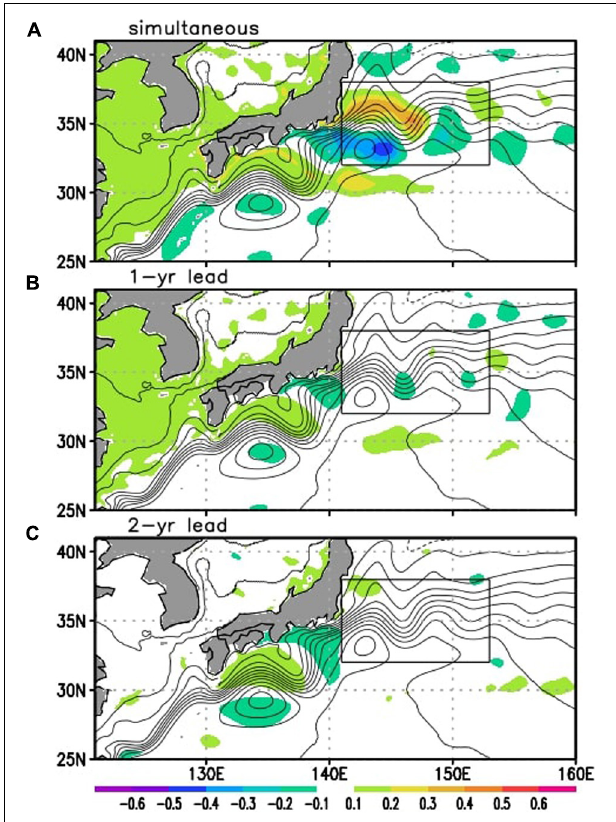
FIGURE 10 | Correlation maps of SSH difference from its ensemble mean with EKE deviations from its ensemble mean in the KE upstream region (indicated by the black rectangle) from all the ensemble members. (A) The simultaneous correlation. (B,C) The lagged correlation maps with SSH fields lead by panel (B) 1 year and (C) 2 years. Regions over a 95% confidence level ( N = 380) are indicated. For the estimation of the correlations, simultaneous and lagged covariances of deviations of SSH and EKE from their ensemble mean, and their variances are calculated from the whole ensemble